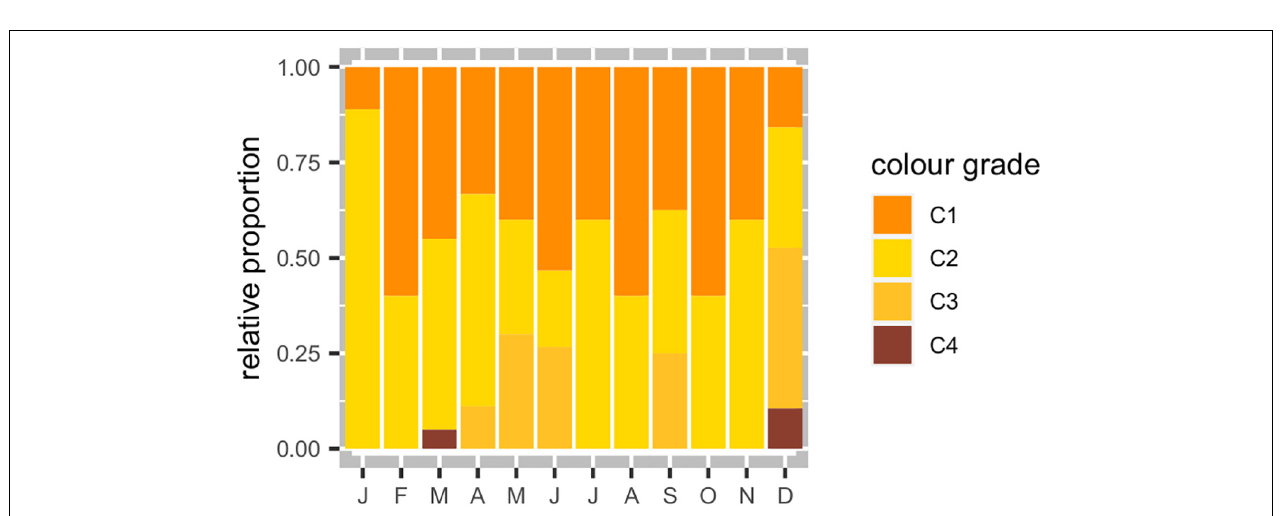
FIGURE 6 | Gonad color distribution observed in the Sphaerechinus granularis population in Madeira archipelago.